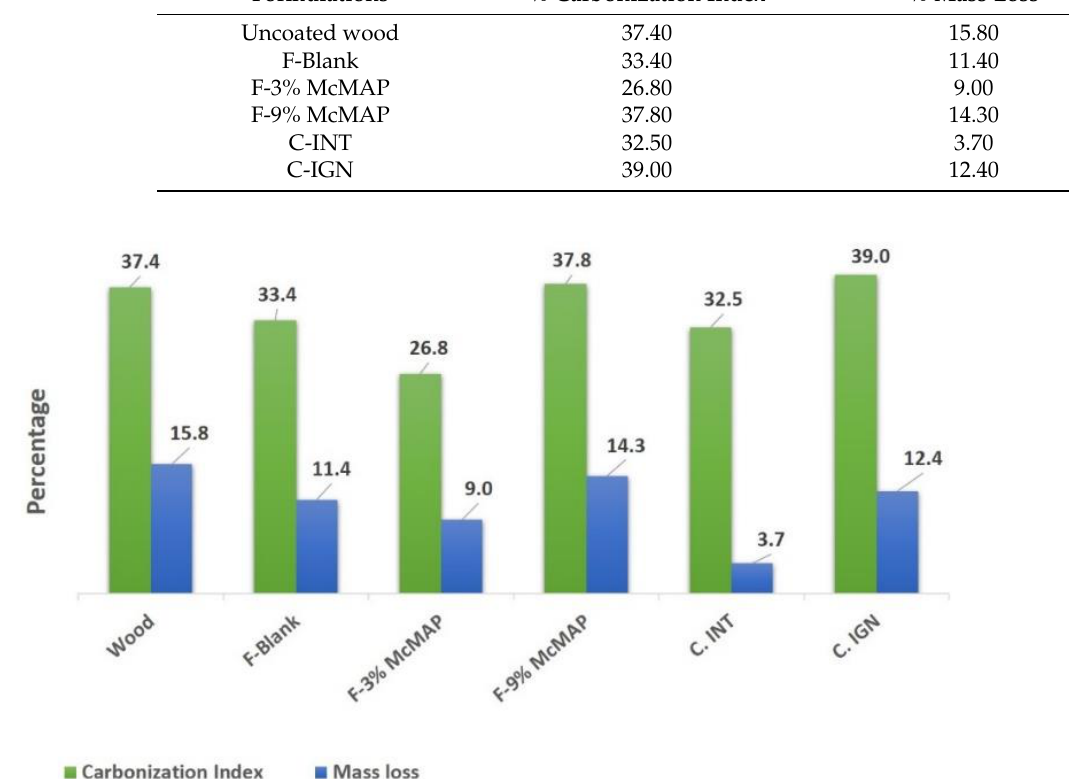
Figure 8. Mass loss and carbonization index of the coatings. Table 7. Mass Loss and Carbonization Index of Coatings.